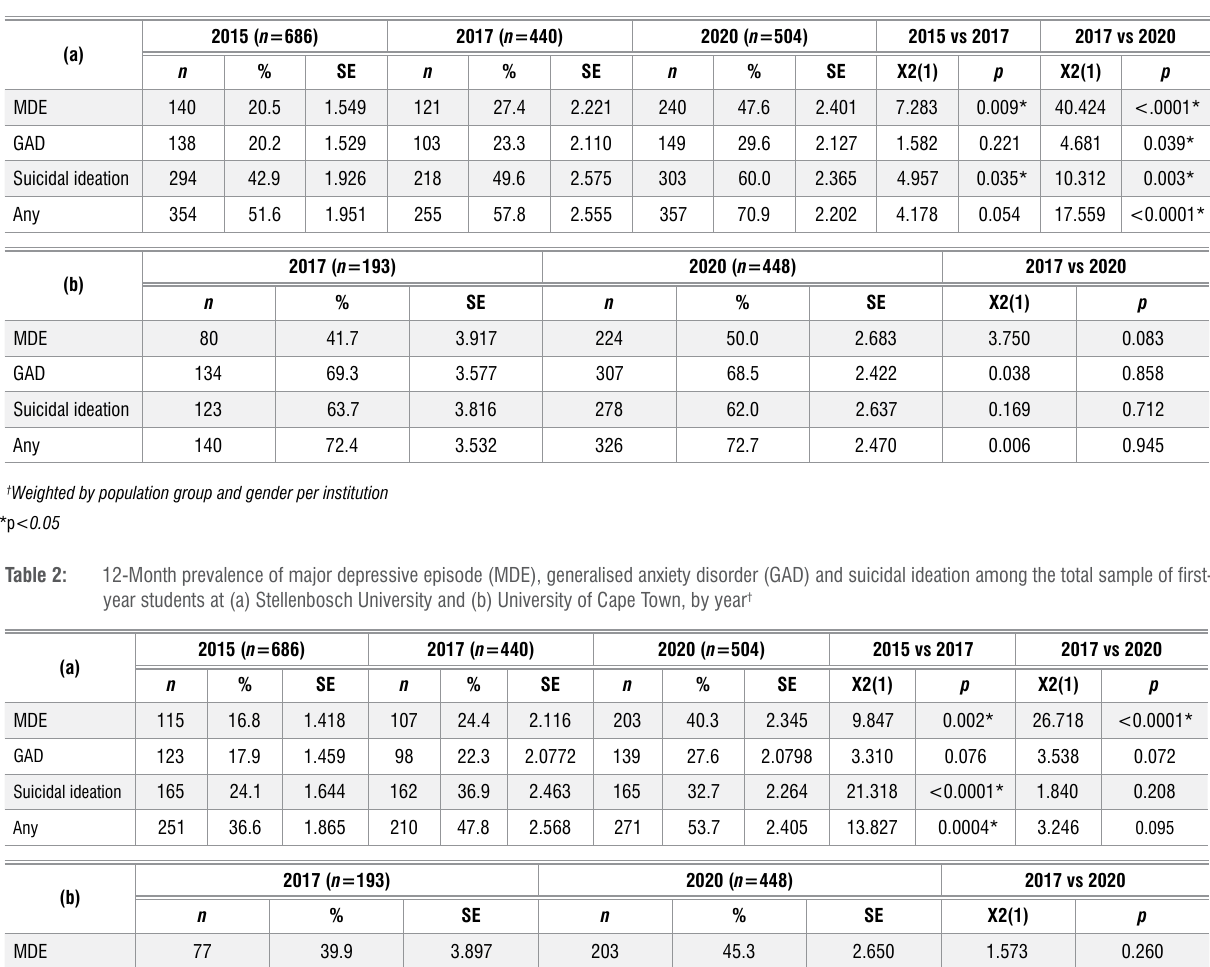
Lifetime prevalence of major depressive episode (MDE), generalised anxiety disorder (GAD) and suicidal ideation among the total sample of first- year students at (a) Stellenbosch University and (b) University of Cape Town, by year †